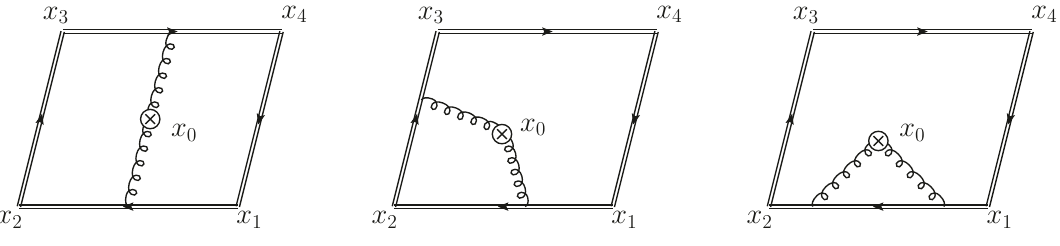
Figure 1 . Representative Feynman diagrams contributing to F (0)